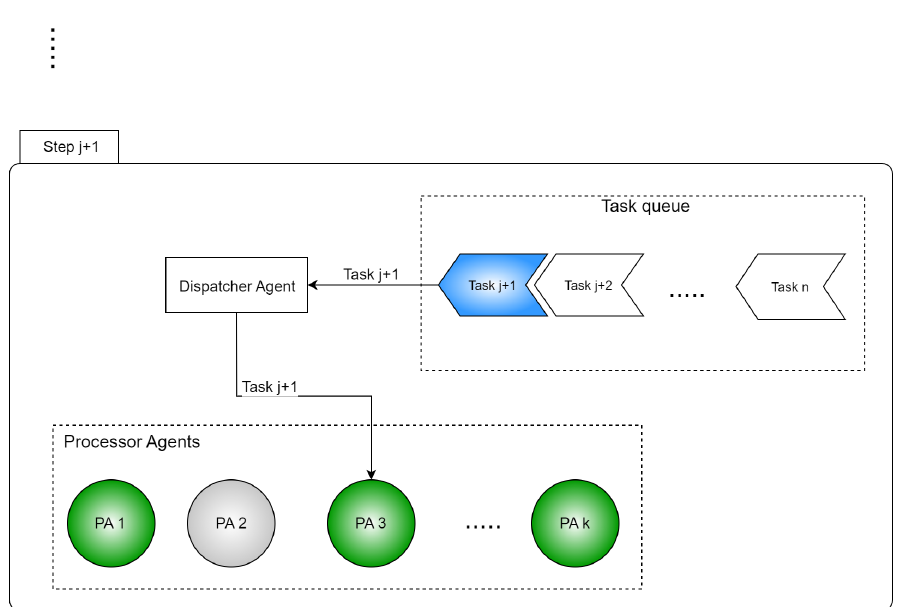
Figure 4. Applied Round Robin